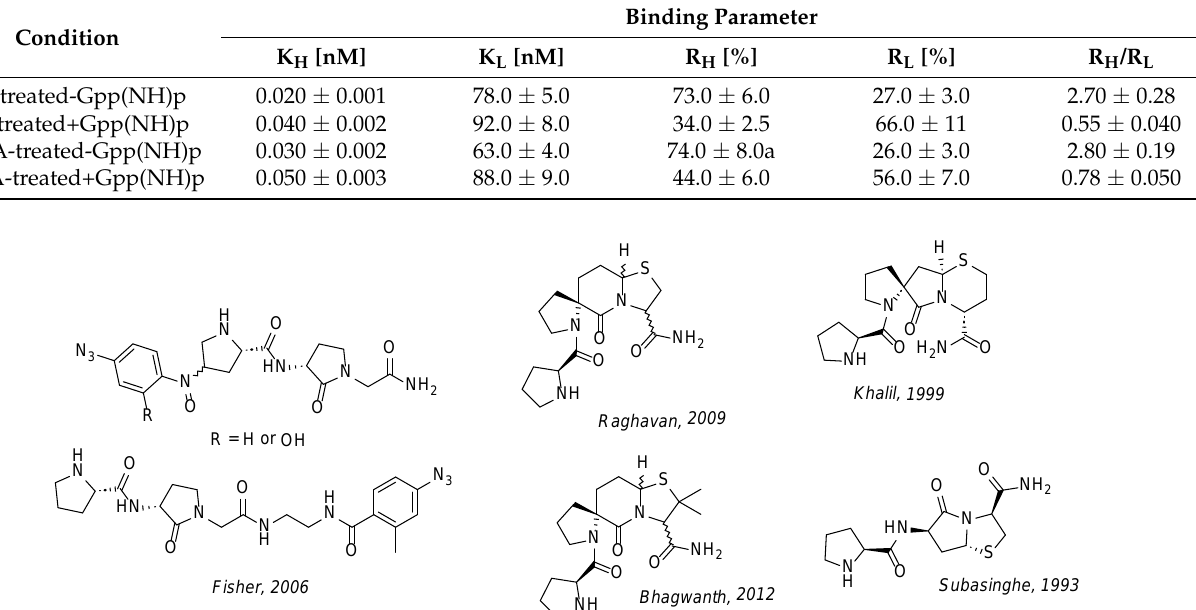
Figure 7. Examples of PLG-derived peptidomimetics.